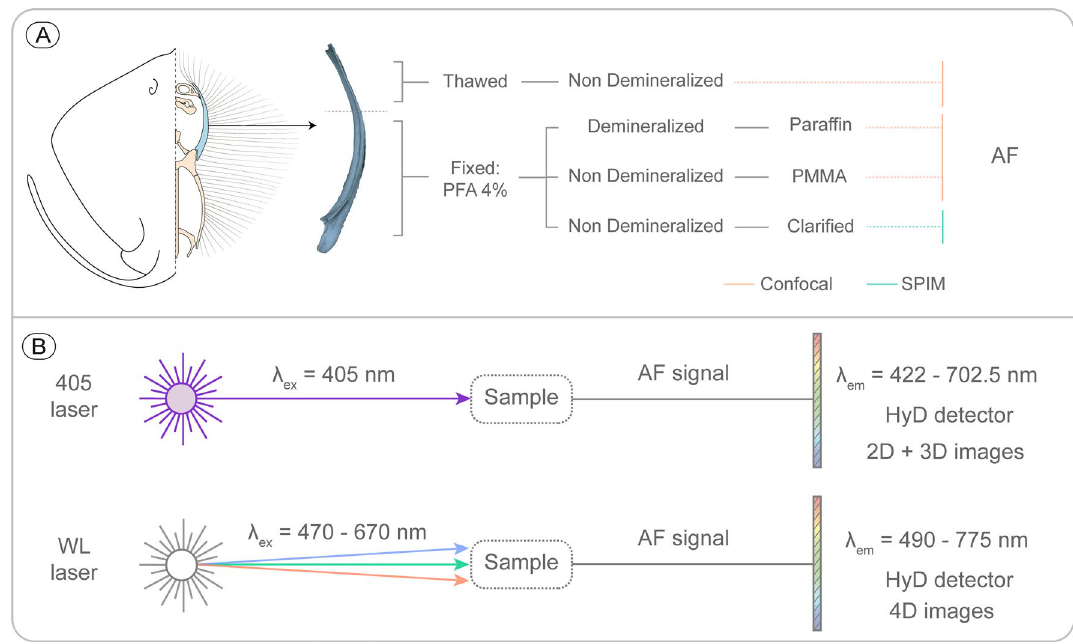
Fig. 2 Scheme of the experimental design. A Different sample preparation methods and microscopes used for their analysis. B Lasers used in the confocal microscope AF analysis. Samples were excited with a 405 nm laser (UV) and White Wavelength Laser (WLL: 470–670 nm, in 10 nm excitation steps). The AF emitted by the samples was collected by detectors with different spectral ranges (listed on the far right), depending on the laser used. 2D and 3D images were generated with the 405 nm laser, whereas 4D images were generated with the WLL (see text for explanation of image types). AF: Autofluorescence